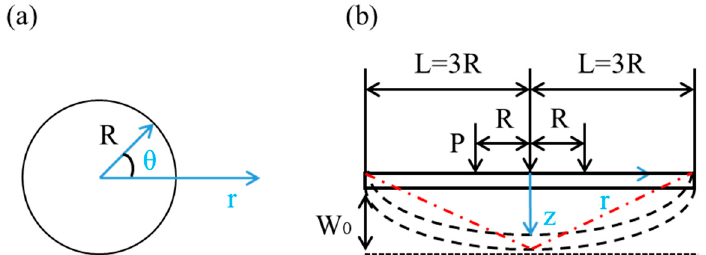
Figure 3. Schematic of concave deformation in laser shock forming. ( a ) polar coordinates ( b ) concave deformation.